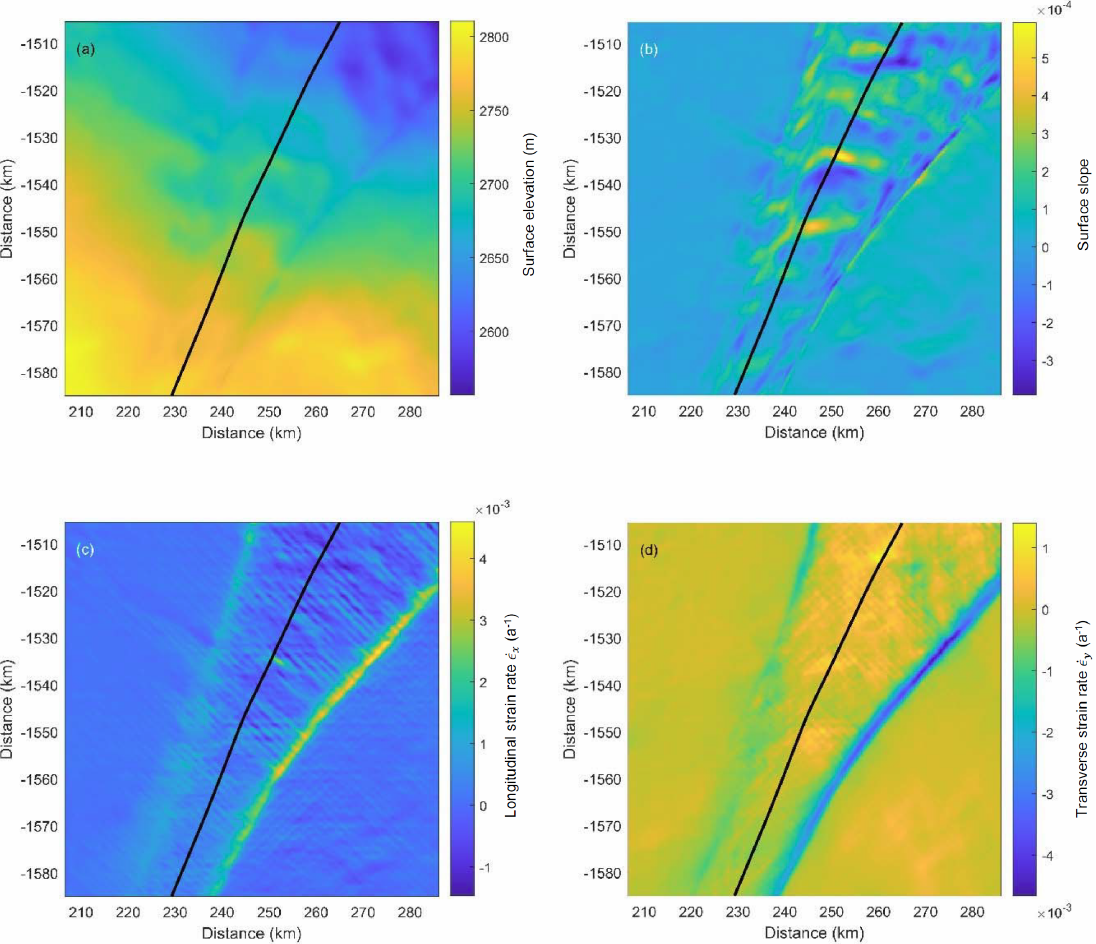
Figure 8. Maps of the 80km × 80km section from Fig. 2 with the central flow line marked: (a) surface elevation in meters and (b) surface slope (dimensionless), both derived from ArcticDEM (Porter et al., 2018), and (c) longitudinal strain rate ˙ (cid:15) x (cid:48) per year along the direction of the flow and (d) transverse strain rate ˙ (cid:15) y (cid:48) per year along the transverse direction to the flow, both from the MEaSUREs Multi-year Greenland Ice Sheet Velocity v1 product (Joughin et al., 2016,